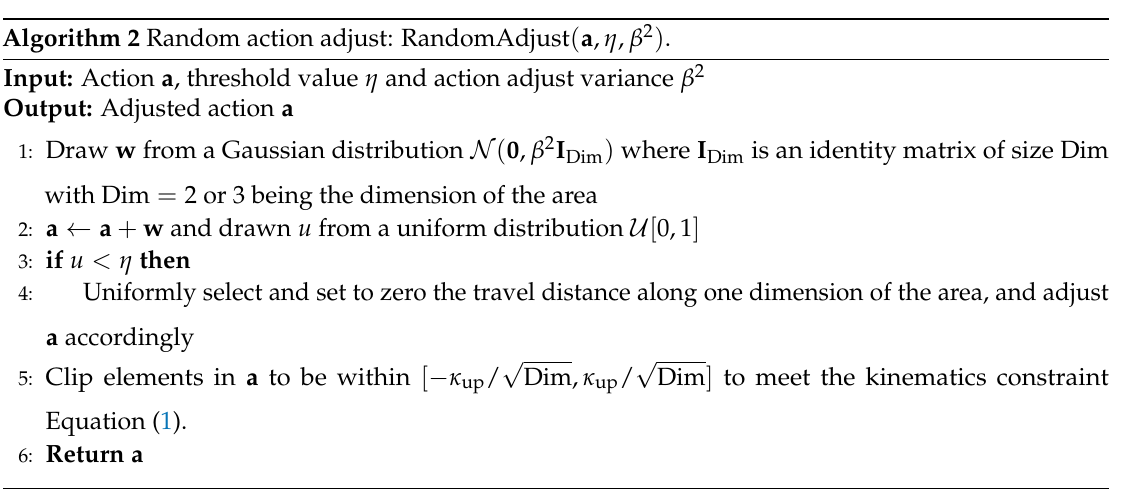
Algorithm 2 Random action adjust: RandomAdjust ( a , η , β 2 )